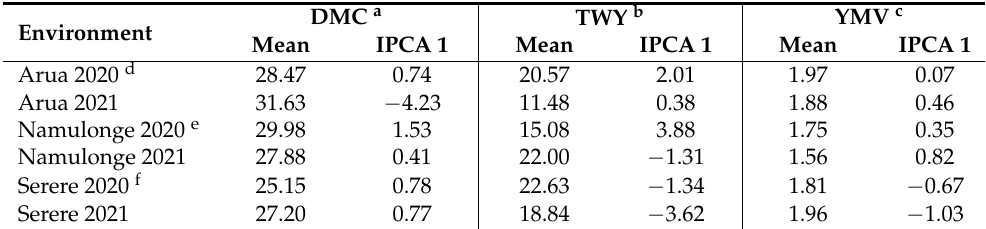
Table 11. Environments’ mean traits and stability index (IPAC 1) scores evaluated across six test environments in Uganda.